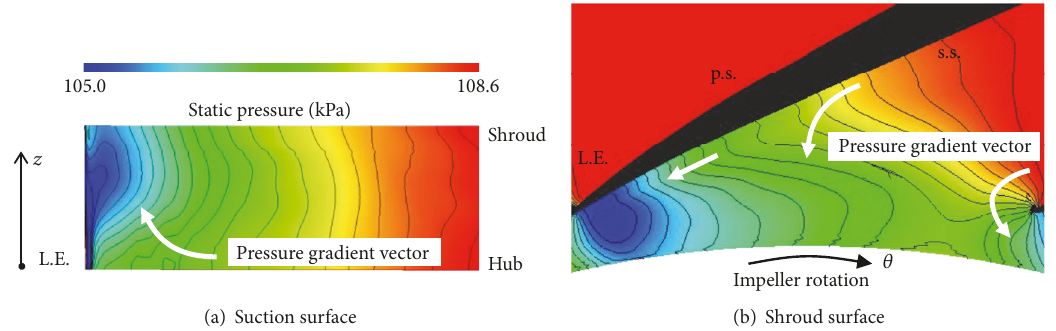
Figure 11: Distribution of static pressure on diffuser suction surface and casing